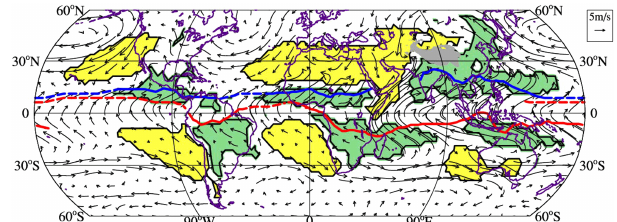
Figure 2. The GM precipitation domain defined by the local summer-minus-winter precipitation rate exceeds 2mmday − 1 , and the local summer precipitation exceeds 55% of the annual total (in green). Summer denotes May through September for the North- ern Hemisphere and November through March for the Southern Hemisphere. The dry regions, where the local summer precipita- tion is less than 1mmday − 1 , are shown (yellow). The arrows show August-minus-February 925hPa winds. The blue lines indicate the ITCZ position for August, and the red lines indicate the ITCZ po- sition for February (solid for monsoon trough and dashed for trade wind convergence). The 3000m height contour surrounding the Ti- betan Plateau is shaded. The merged Global Precipitation Climatol- ogy Project/Climate Prediction Center Merged Analysis of Precipi- tation data and ERA interim data were used for 1979–2012.